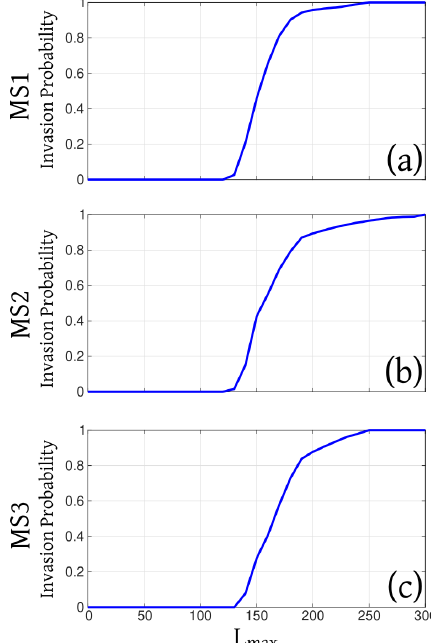
Figure 3. Cumulative curves PDC invasion probability of the marker sites (a) MS1, (b) MS2, (c) MS3, for a set of simulations performed using the program BoxMapProb (Aravena et al., 2020) as a function of the parameter L max , which represents the runout dis- tance on a flat surface. To perform these simulations, vent positions are uniformly sampled within the Aso caldera, the volume of pyro- clasts is uniformly sampled between 10 9 and 10 12 m 3 , and the other input parameters are derived from expert judgment (see Table 1 – 5000 samples). We observe that L max of 195, 235 and 225km en- sure that most of the simulations ( > 95%) invade the MS1, MS2, MS3,